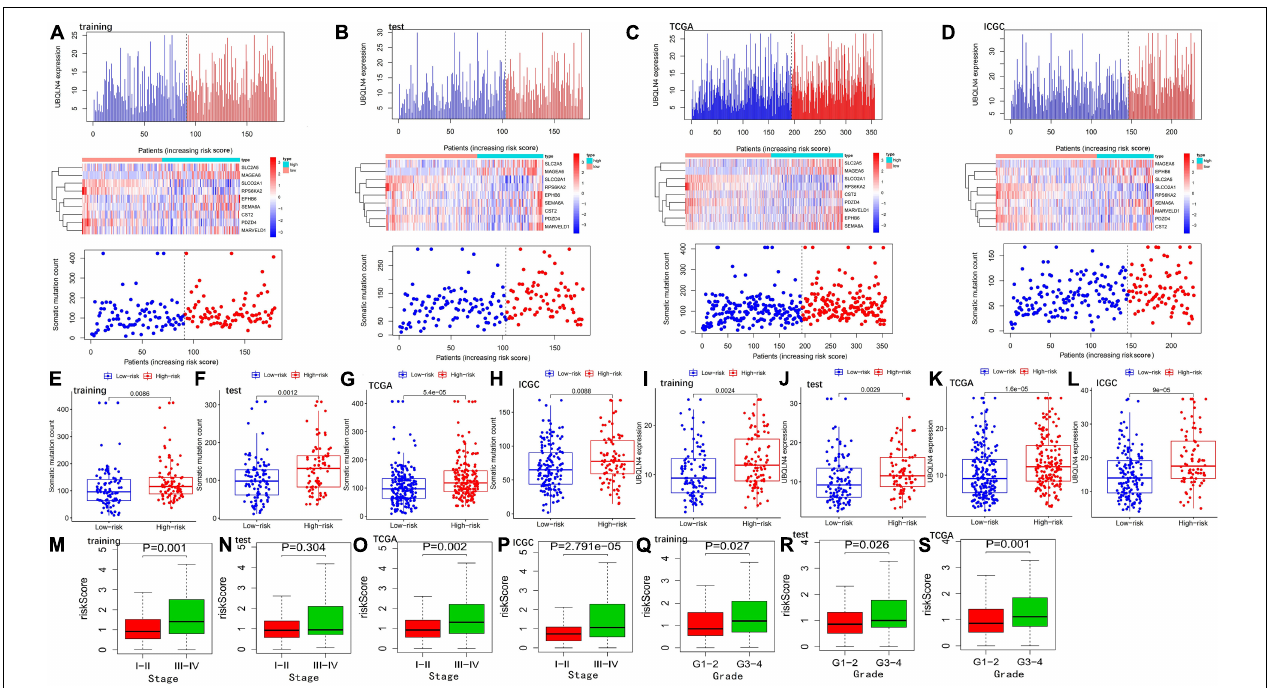
FIGURE 2 | Evaluation of the GIGSig in the training, test, TCGA, and ICGC sets. The expression patterns of GIGs in GIGSig and the distribution of somatic mutation count distribution and UBQLN4 expression for patients in high- and low-risk groups in the training set (A) , test set (B) , TCGA set (C) , and ICGC set (D) . The distribution of somatic mutation and UBQLN4 expression in patients of high- and low-risk groups in the training set (E,I) , test set (F,J) , TCGA set (G,K) , and ICGC set (H,L) . Box plot of correlation between the risk score and clinical stages in the training set (M) , test set (N) , TCGA set (O) , and ICGC set (P) . Box plot of correlation between the risk score and tumor grade in the training set (Q) , test set (R) , and TCGA set (S) . Horizontal lines: median